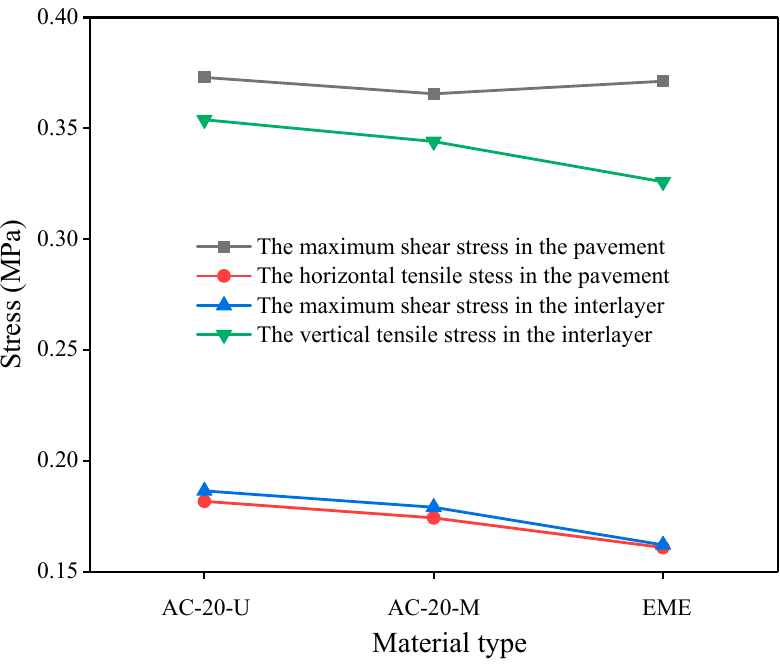
Figure 4. The stress responses in the bottom layer of various pavement structures. It can be seen from Figure 4 that with the increase of the asphalt mixture modulus, the maximum shear stress in the pavement was almost unchanged. The transverse tensile stress in the pavement, the horizontal shear stress at the interlayer, and the vertical tensile stress at the interlayer showed a downward trend. This was attributed to the fact that with the modulus increase of the lower layer pavement, the stiffness was also increasing, which alleviated the effect of the bridge deck’s deformation on the pavement structure, which decreased the lateral tensile stress within the pavement structure [16,17]. On the other hand, since the difference between the modules of the pavement and the concrete bridge structure was reduced, the maximum horizontal shear stress and vertical tensile stress between the layers were reduced [18]. The high-modulus asphalt pavement mixture made the whole structure of the deck pavement system more coordinated, hence achieving the purpose of improving the pavement stress